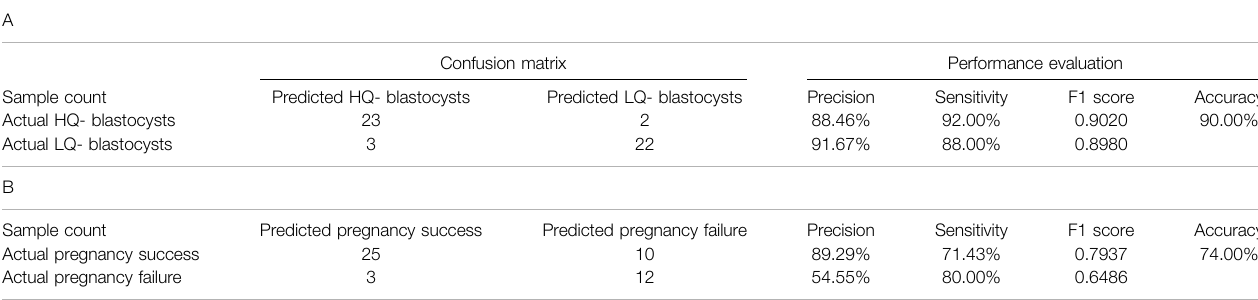
TABLE 3 | Confusion matrix and performance evaluation of ANN classi fi cation models for an independent testing set of 50 Raman spectra.